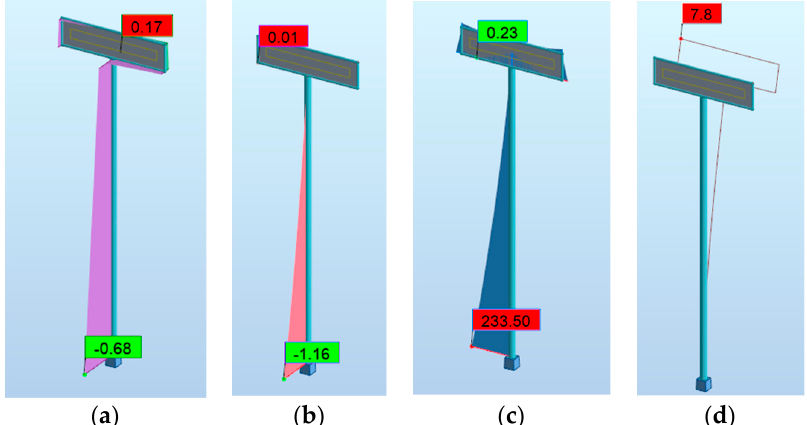
Figure 18. Obtained results of internal forces: ( a ) shear force, ( b ) bending moments, ( c ) stresses and ( d ) deflections.